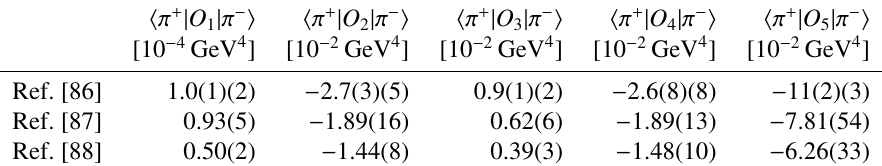
= 3GeV, from lattice MS